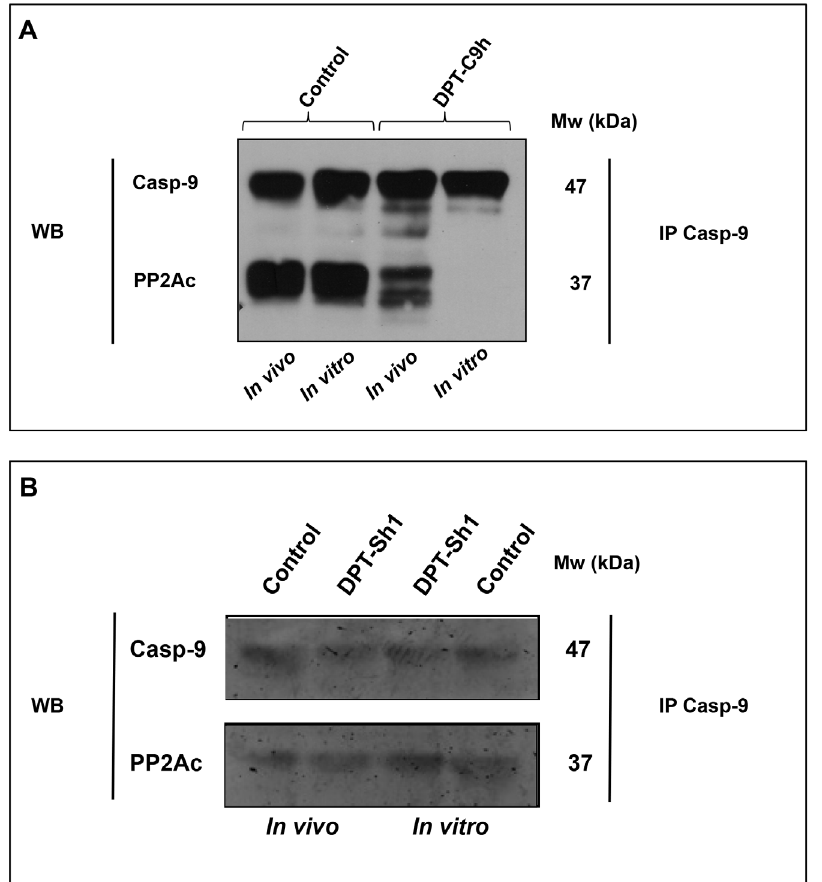
Figure 1. DPT-C9h competes in invitro and invivo caspase-9/PP2Ac interaction. A) In vivo competition of caspase-9/PP2Ainteraction. The HBCx-12A breast cancer cell line was cultured for 24 h in the presence or the absence (control) of DPT-C9h (100 m M); cells were lysed and cytoplasmic extracts immunoprecipitated with anti-caspase-9 antibody and immunoblotted with anti-PP2Ac and anti-caspase-9 antibodies. In vitro competition of the caspase-9/PP2A interaction. Cytoplasmic lysates from HBCx-12A cells were immunoprecipitated with anti-caspase-9 antibody; the caspase-9/ PP2Ac interaction was competed in vitro with 1.5 mM of DPT-C9h peptide for 30 min at room temperature; immunoprecipitates were washed and immunoblotted with anti-PP2Ac and anti-caspase-9, the latter as internal control of protein loading. B) The HBCx-12A cell line was cultured in the presence or the absence (control) of the shuttle DPT-Sh1 (100 m M) for 24 h and the in vitro and in vivo competition of caspase-9/PP2A interaction was analyzed as above.